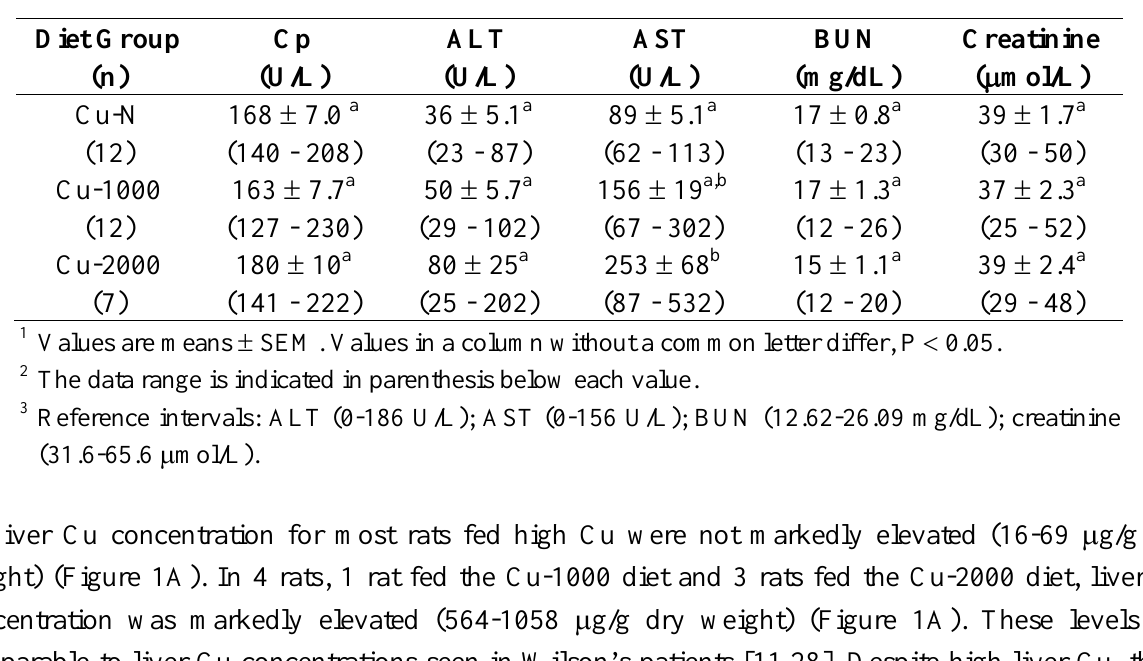
Table 3. Plasma Cp activity and serum ALT, AST, BUN and creatinine of rats fed diets normal or high in Cu for 13 weeks 1,2,3